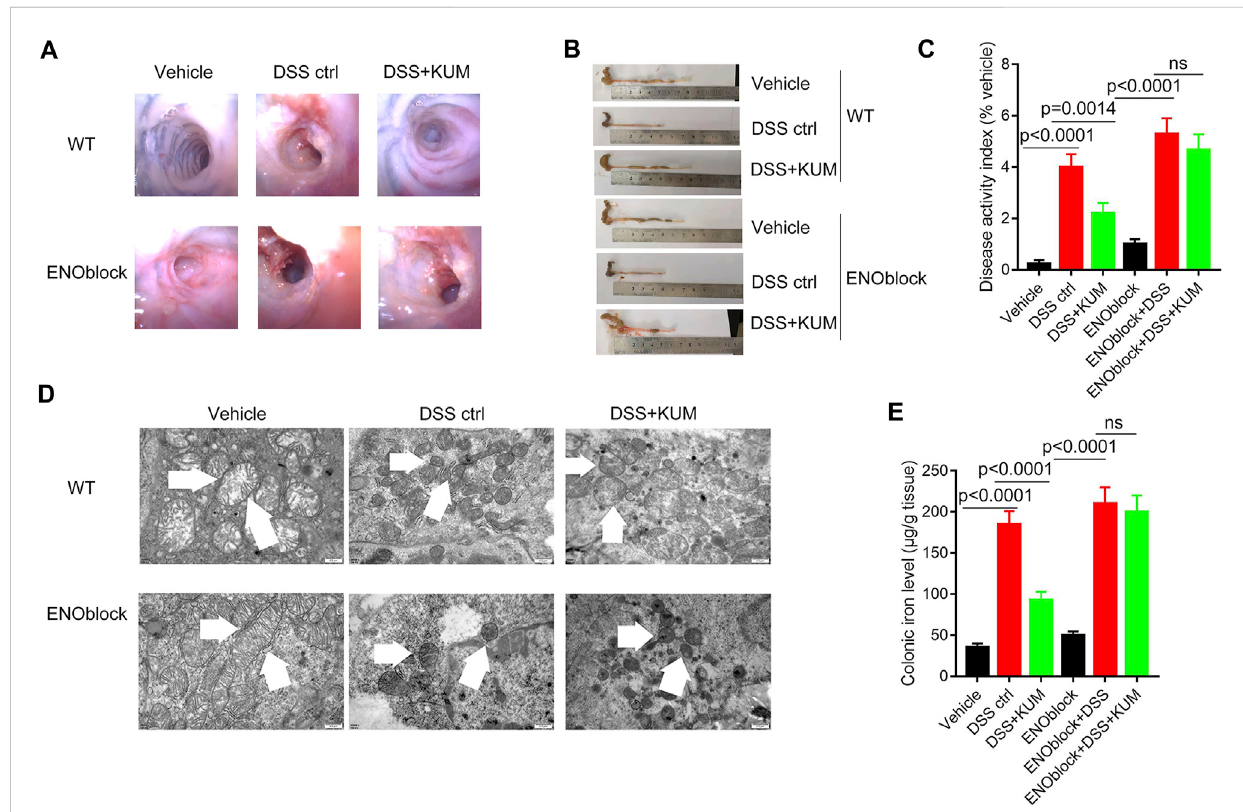
FIGURE 5 KnockdownofEno3signi fi cantlyreversedkumatakenin-inducedregulationofepithelialferroptosisincolitismice.MicewereadministeredtheENO inhibitor ENOblock by intraperitoneal injection 3 days before DSS or kumatakenin treatment, and the effects of kumatakenin on (A) vascular patterns, atrophyofintestinalvilli, (B) colonlength, (C) diseaseactivityindex, (D) epithelialmitochondrialmorphology(scalebar=0.5 μ m)and (E) cellularironlevels in epithelial cell in colitis mice were measured. KUM,